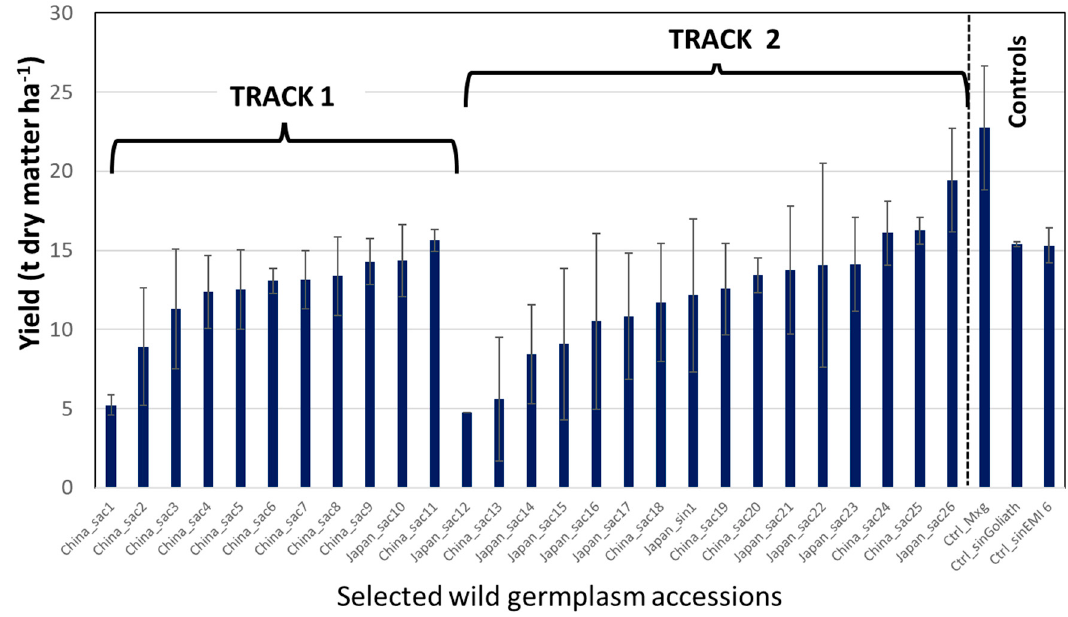
Figure 3. Spring harvestable yield (t dry matter ha − 1 ) for selections from Track 1 (11 M. sacchariflorus accessions from seed) and Track 2 (16 selections, cloned by in vitro propagation) and three control genotypes (standard M × g ), M. sinensis (Goliath and EMI-6, [6]), following the third growing season at the JKI site in Braunschweig (March 2012). Data from three plots of 50 plants with a planting density of 2 plants m − 2 , each in a randomised block. The field design is similar to those in [4]. Error bar = +/ − 1 SE.